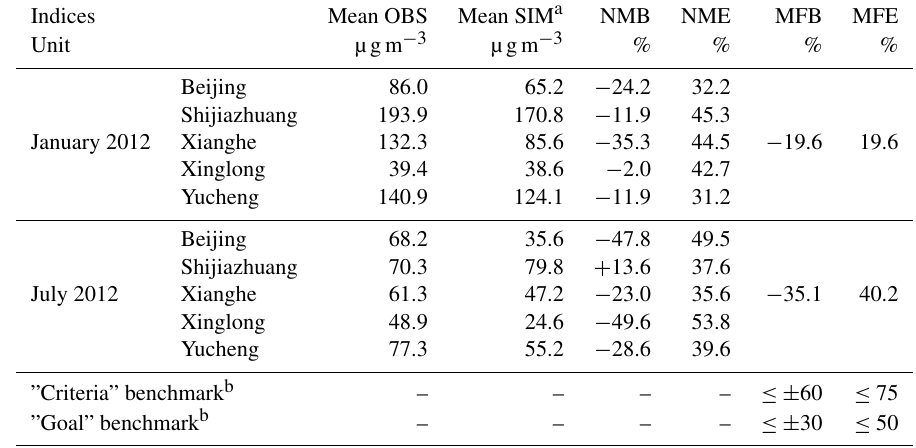
Table 2. Comparison of the simulated and observed PM 2 . 5 concentrations at five sites.